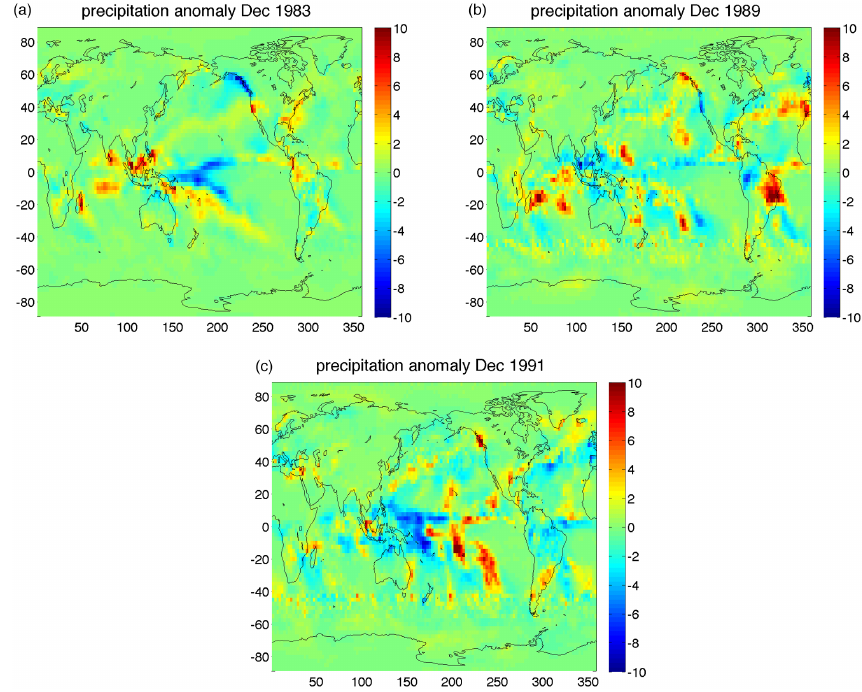
Figure 10. Anomalies of precipitations in December 1983 (a) , 1989 (b) and 1991 (c) (December 1983, 1989 and 1991 minus December 1979–1995) from the GPCP data